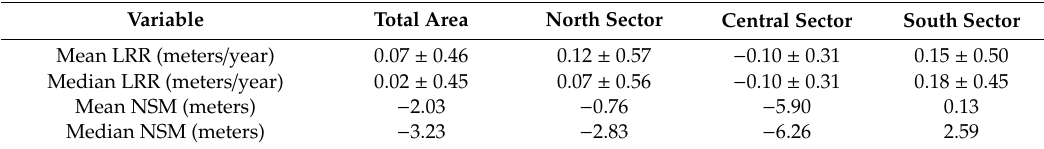
Table 4. Evolution rates between 1981 and 2017.